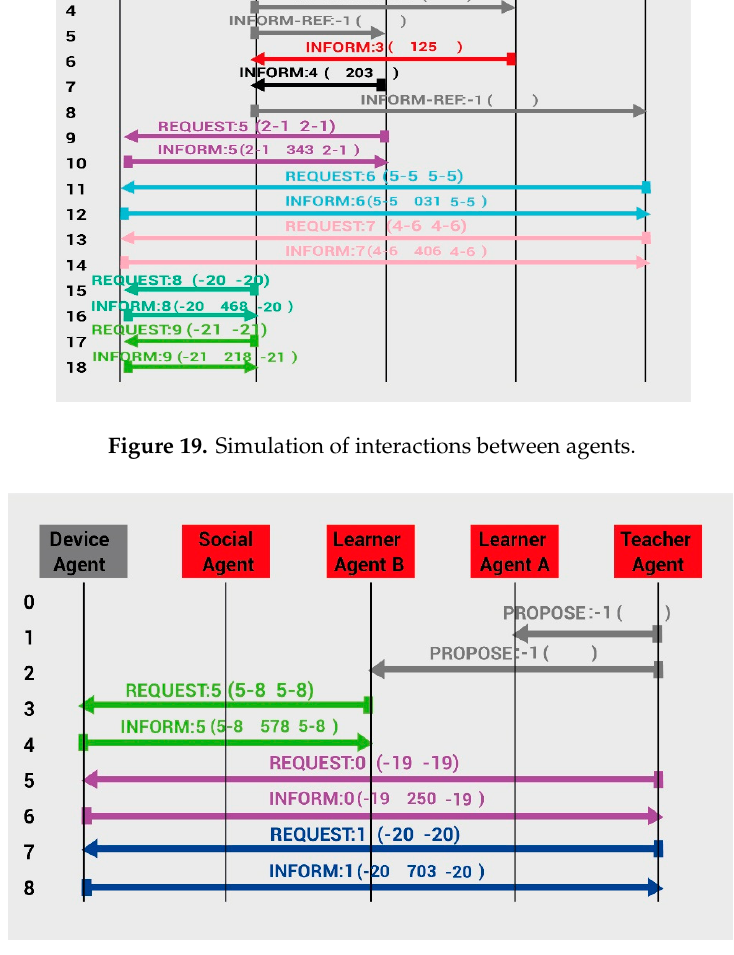
Electronics 2020 , 9 , x FOR PEER REVIEW Figure 20. Simulation of interactions between teacher agents and other agents. Figure 20. Simulation of interactions between teacher agents and other agents.